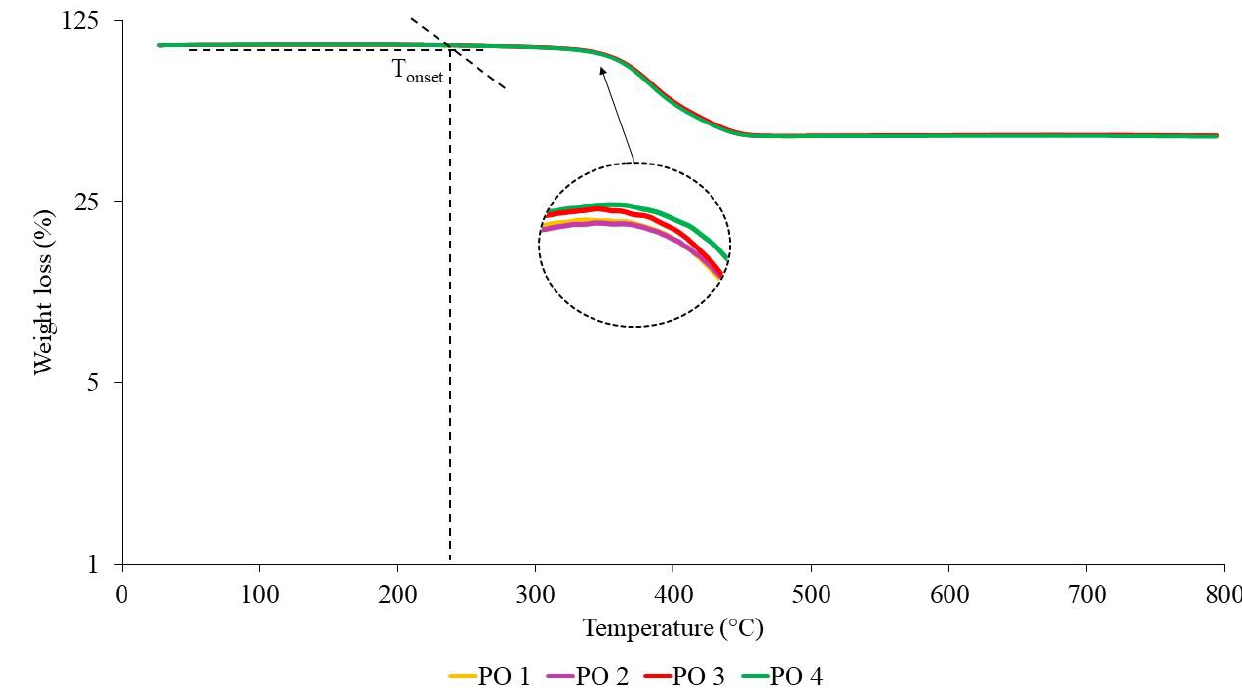
Figure 12. TGA curves of NR-based MREs for different ratios of PO:AO.